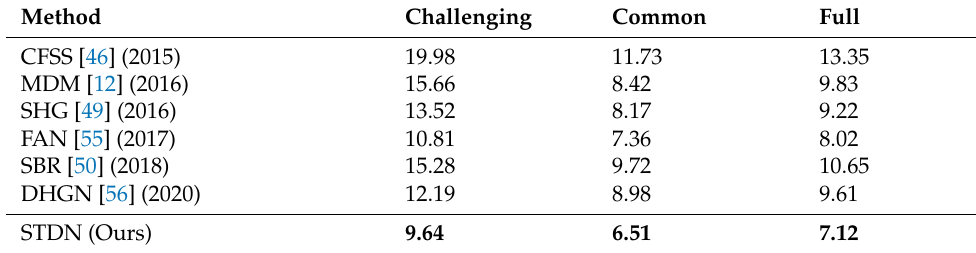
Table 5. NME (in %) of 68-point landmark detection on Masked 300